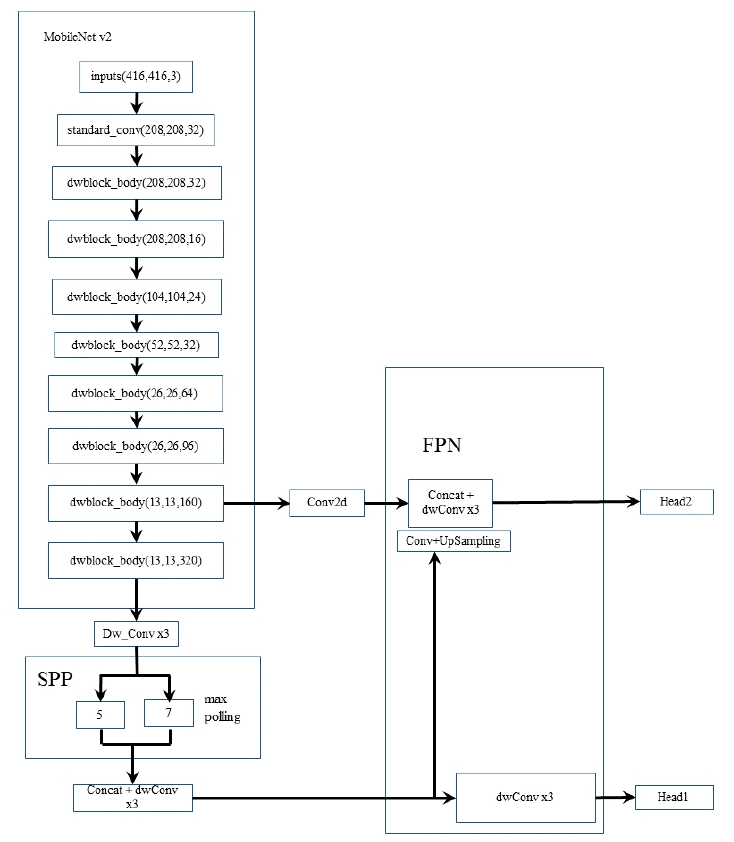
Figure 5. The network architecture of our wild animal detection system. After the PW-DW-PW operation, the parameters reduce to 1/8 to 1/9 of the original. Assume that the size of the feature map is D H , D W , and the size of the convolution kernel is D K , D K . The input feature dimension is M , the output feature dimension is N , the parameter quantity of the standard convolution is D K × D K × M × N , and the calculation quantity is D K × D K × M × N × D H × D W . If PW-DW-PW convolution is used, the parameters and calculation amount will be reduced to D K × D K × M + M × N and alleviate the problem of non-circulation of feature information space dimensions caused by DW convolution. In addition, batch normalization ensures the smooth transmission of gradient information while accelerating convergence [44]. Different from the original MobileNet inverted residuals design, in the comparison network, the network structure we designed is not directly passed to the next layer of convolution after the short